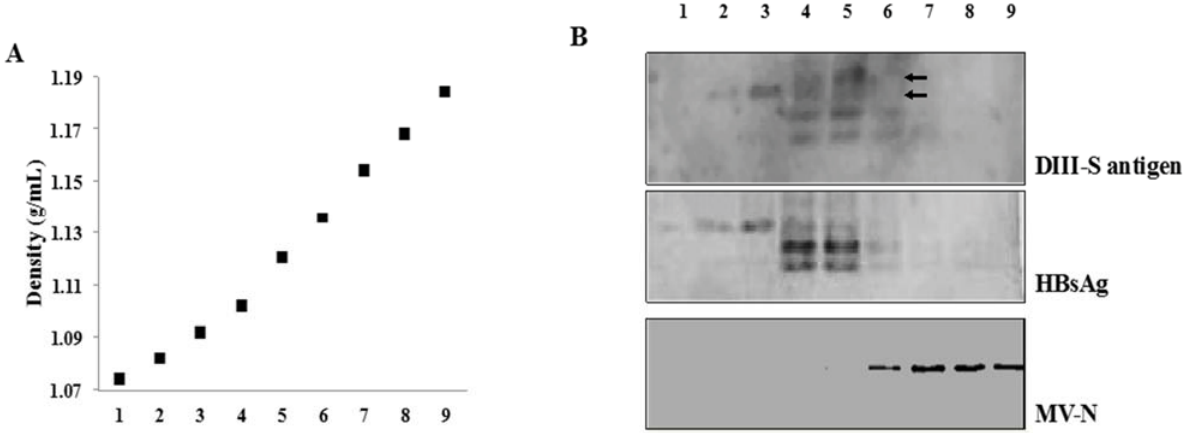
Figure 4. ( A ) Materials released from Vero/hSLAM cells infected with MVvac2DIII-S,S)P or MVvac2(HBsAg)N collected 72 h after infection were clarified, and particulate material pelleted, loaded on a 20% to 60% sucrose gradient, and centrifuged to equilibrium. Five hundred microliter fractions were collected from the top (left) to the bottom (right) and weighed. The dotted line shows a representative density profile. ( B ) Aliquots of each fraction were separated by 12.5% SDS-polyacrylamide gel electrophoresis, immunoblotted, and probed with anti-HBsAg antibodies for fractions coming from cells infected with MVvac2DIII-S,S)P (upper panel) or MVvac2(HBsAg)N (medium panel). The lower panel indicates the migration of infectious MV